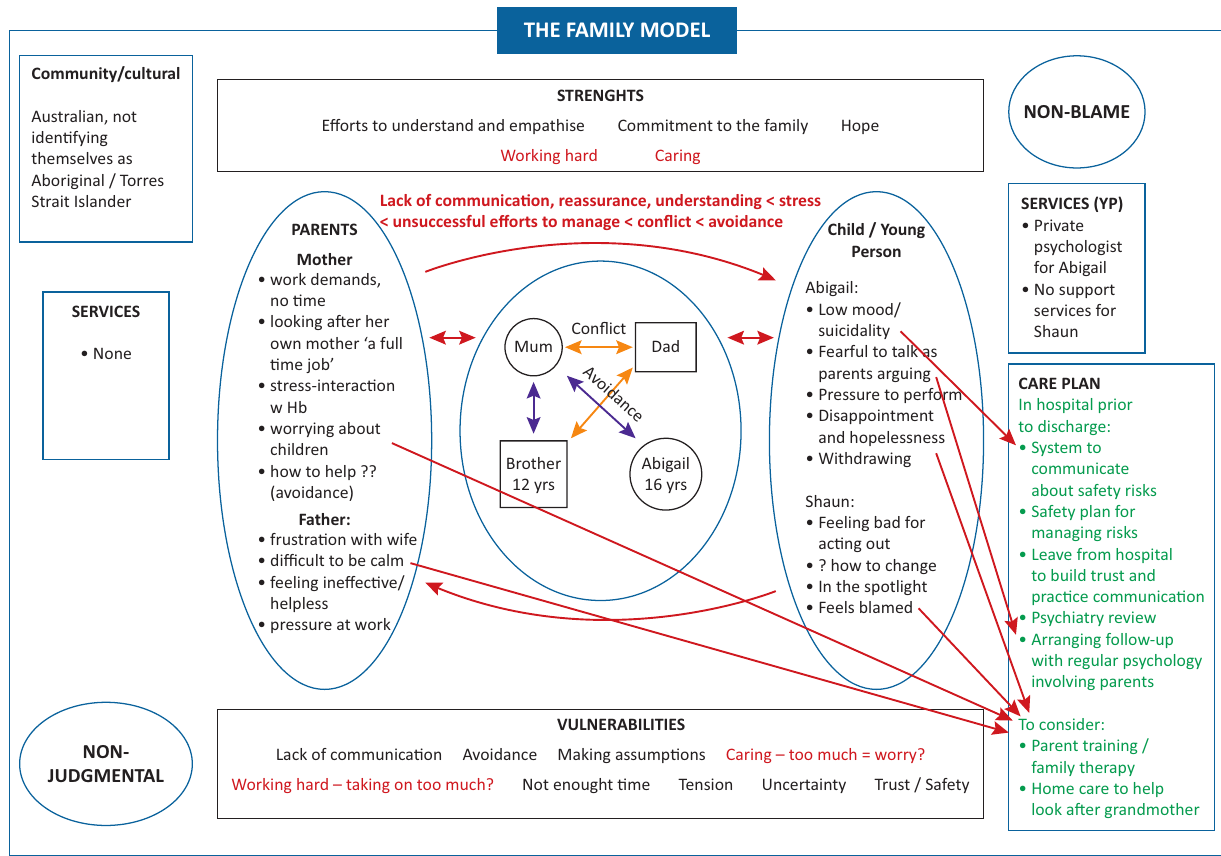
Figure 4. Paediatric inpatient